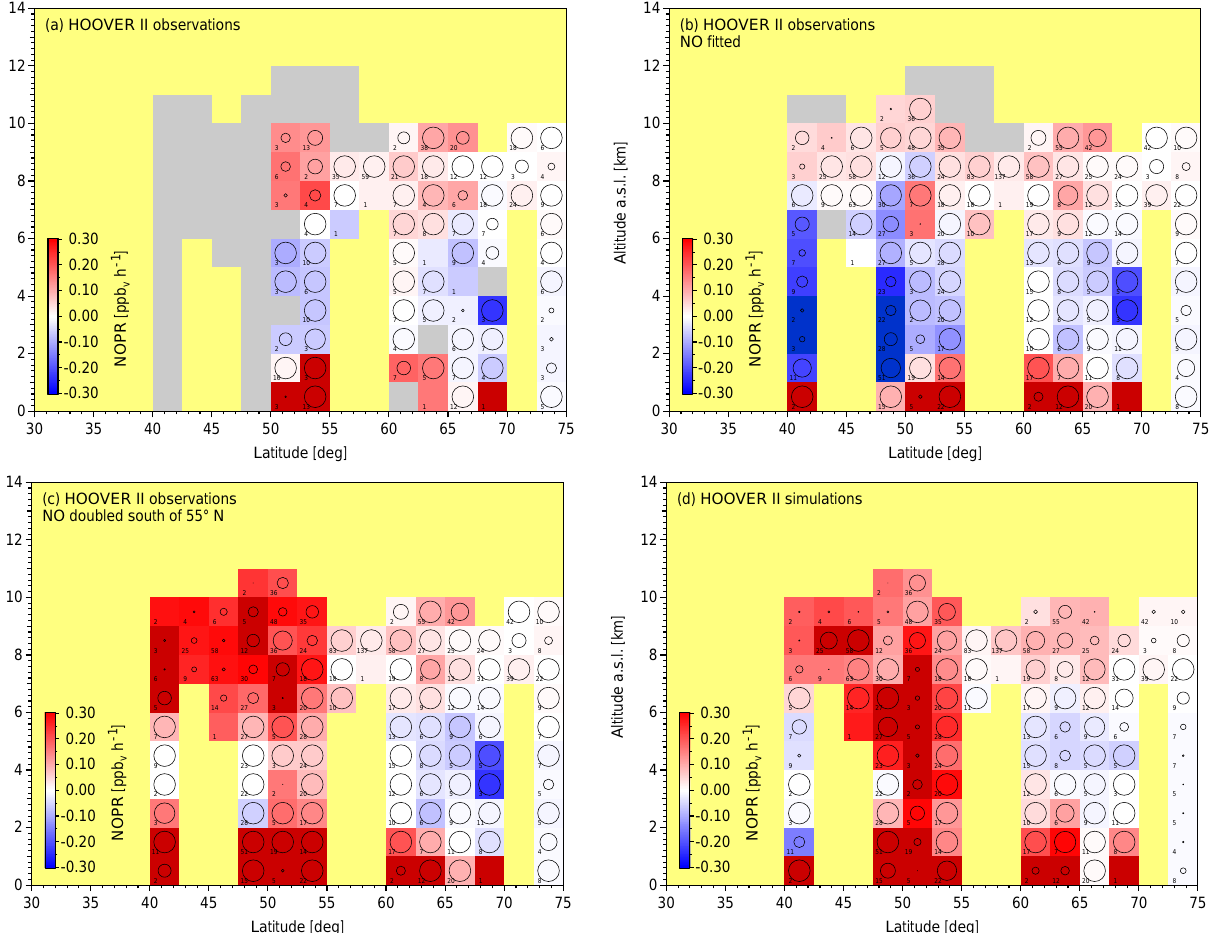
Figure 6. Net ozone production rates (NOPR) in ppbvh − 1 calculated from in situ data (a) , fitted NO (b) , double NO (c) and from MATCH simulations (d) for HOOVER